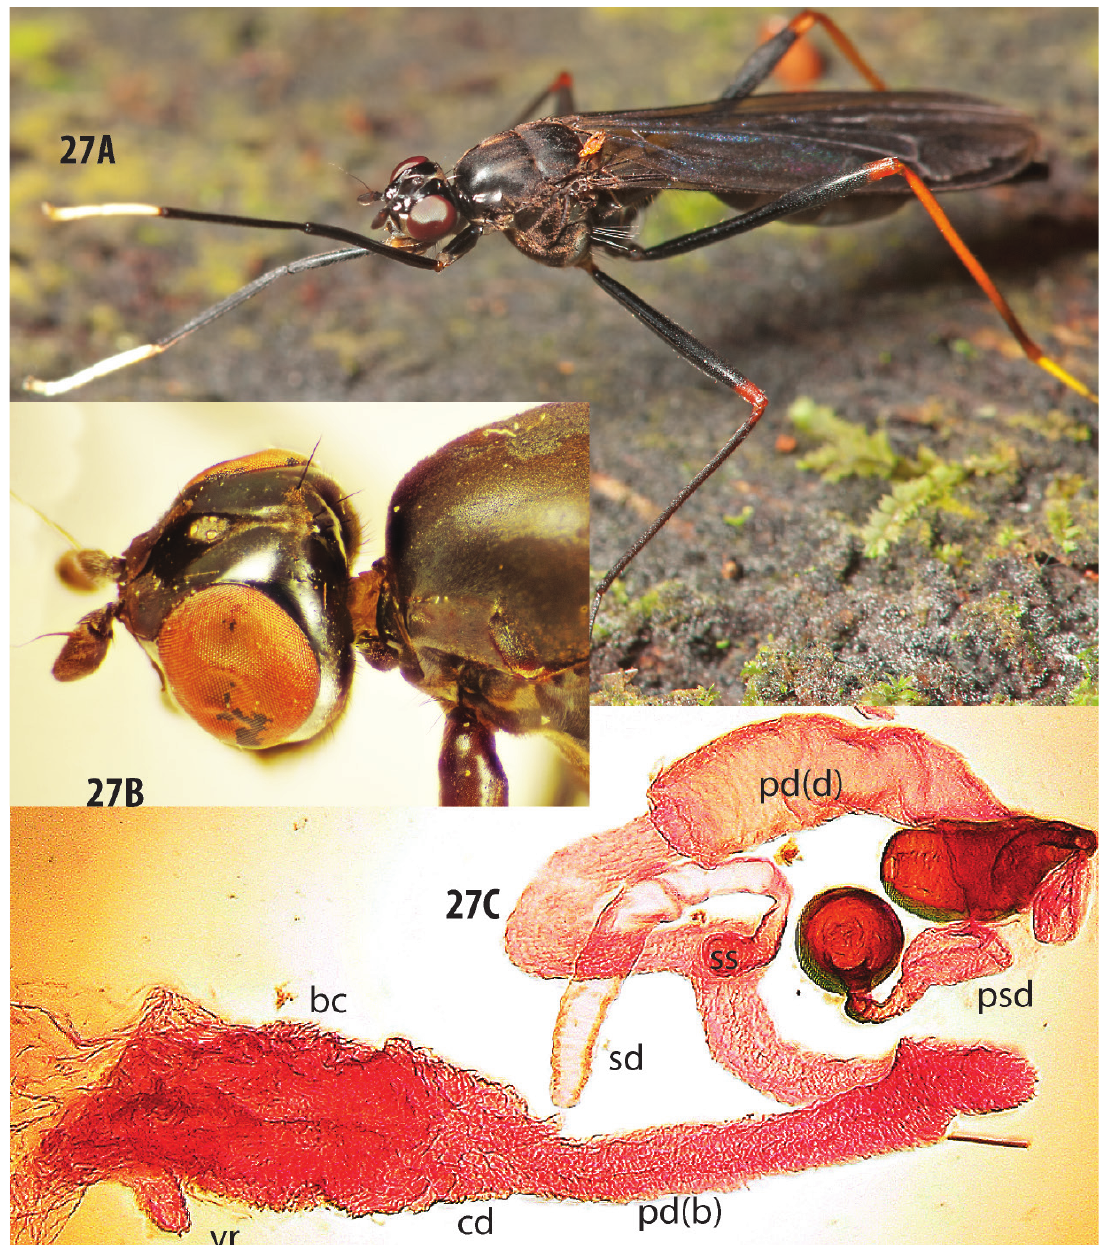
Fig. 27. Mesoconius notacca sp. nov. A . Paratype prior to capture, ♀, DEBU. B . Head and anterior thorax. C . Spermathecae and associated structures. Abbreviations: bc = bursa copulatrix; cd = common duct; pd(b) = paired spermathecal duct (basal); pd(d) = paired spermathecal duct (distal); psd = paired spermathecal duct; sd = single spermathecal duct; ss = single spermatheca; vr - ventral